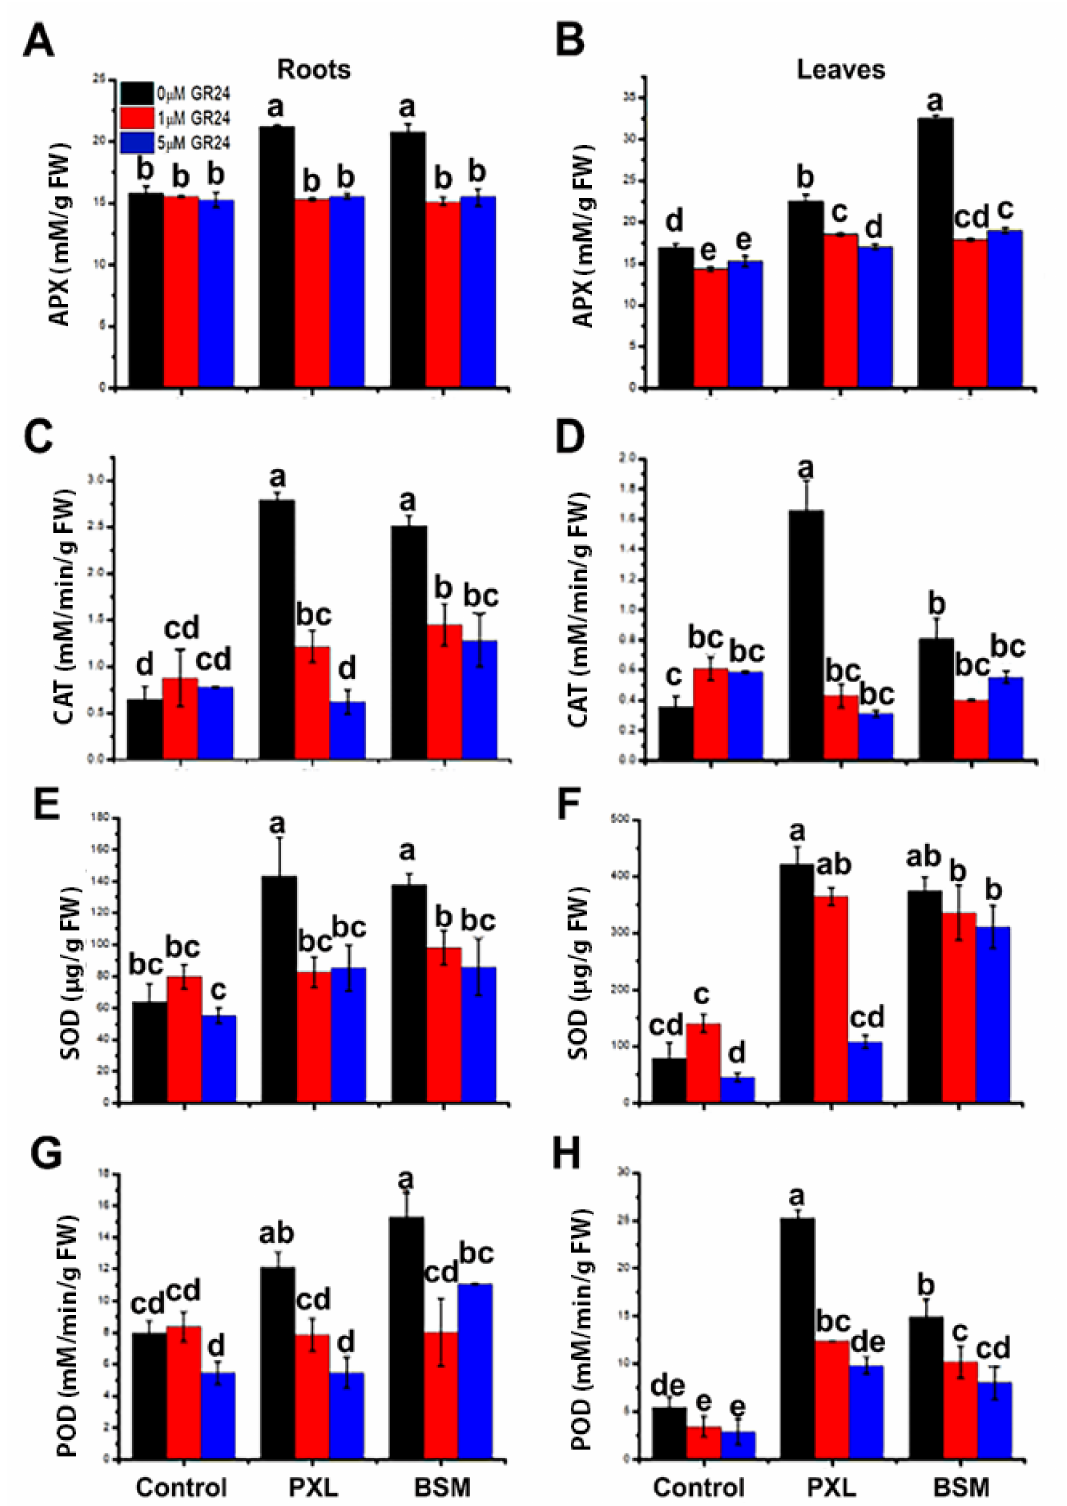
Figure 2. Effect of different concentrations of SL with and without herbicides on roots and leaves antioxidant activities. ( A , B ) APX, ( C , D ) CAT, ( E , F ) SOD, and ( G , H ) POD in roots and leaves, respectively. Different letter shows a significant difference ( p < 0.01) from each other. Data is the mean of three independent replicates. ANOVA was conducted separately for roots and